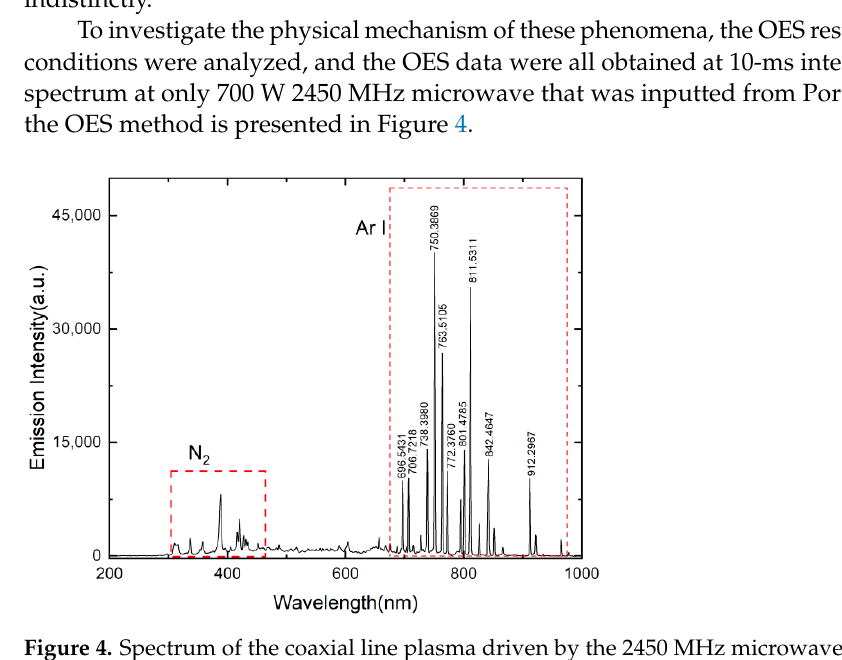
Figure 4. Spectrum of the coaxial line plasma driven by the 2450 MHz microwave from Port 1 at a power of 700 W and pressure of 80 Pa.